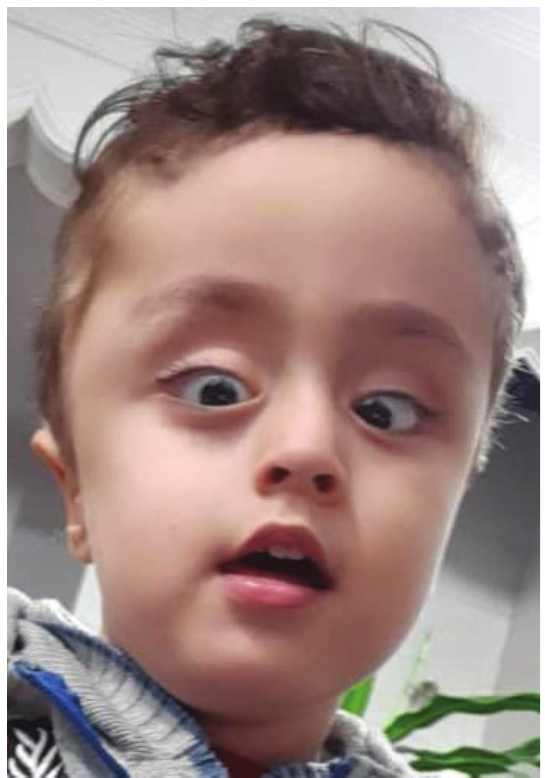
Figure 5 : Patient after four years of initial